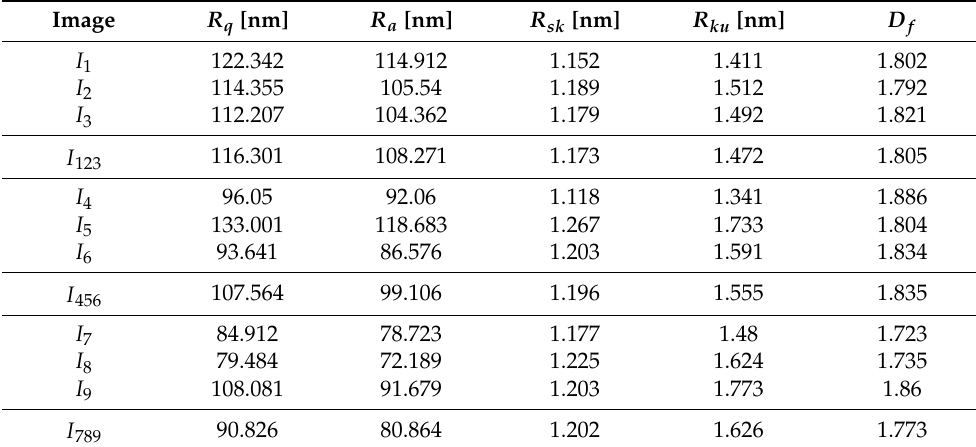
Table 1. Roughness and diffractal coefficients of FE-SEM